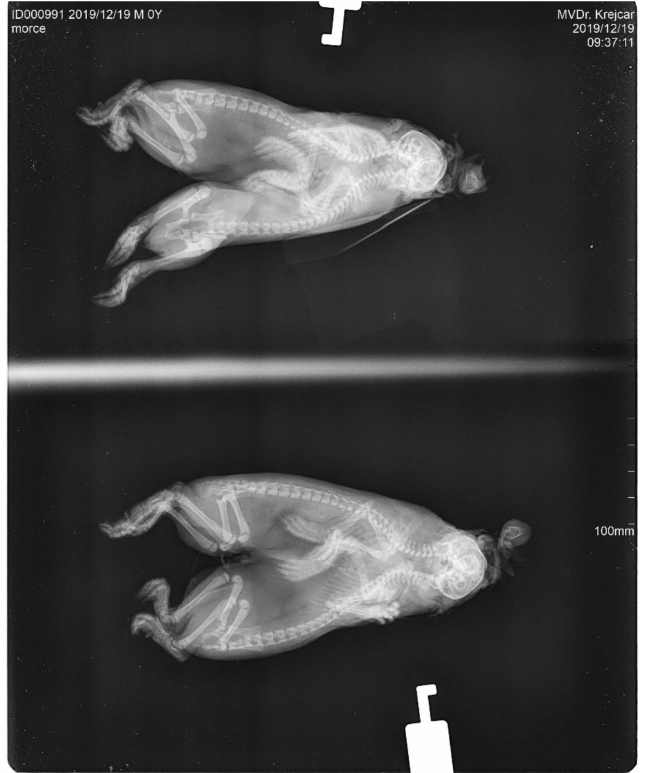
Figure 3. The X-ray images—side projection